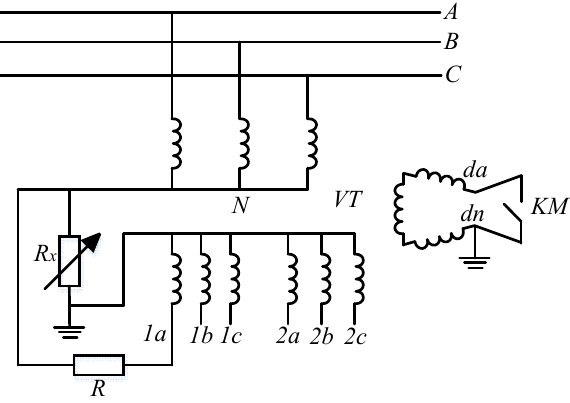
Figure 3. Scheme for the online detection of VT insulation.